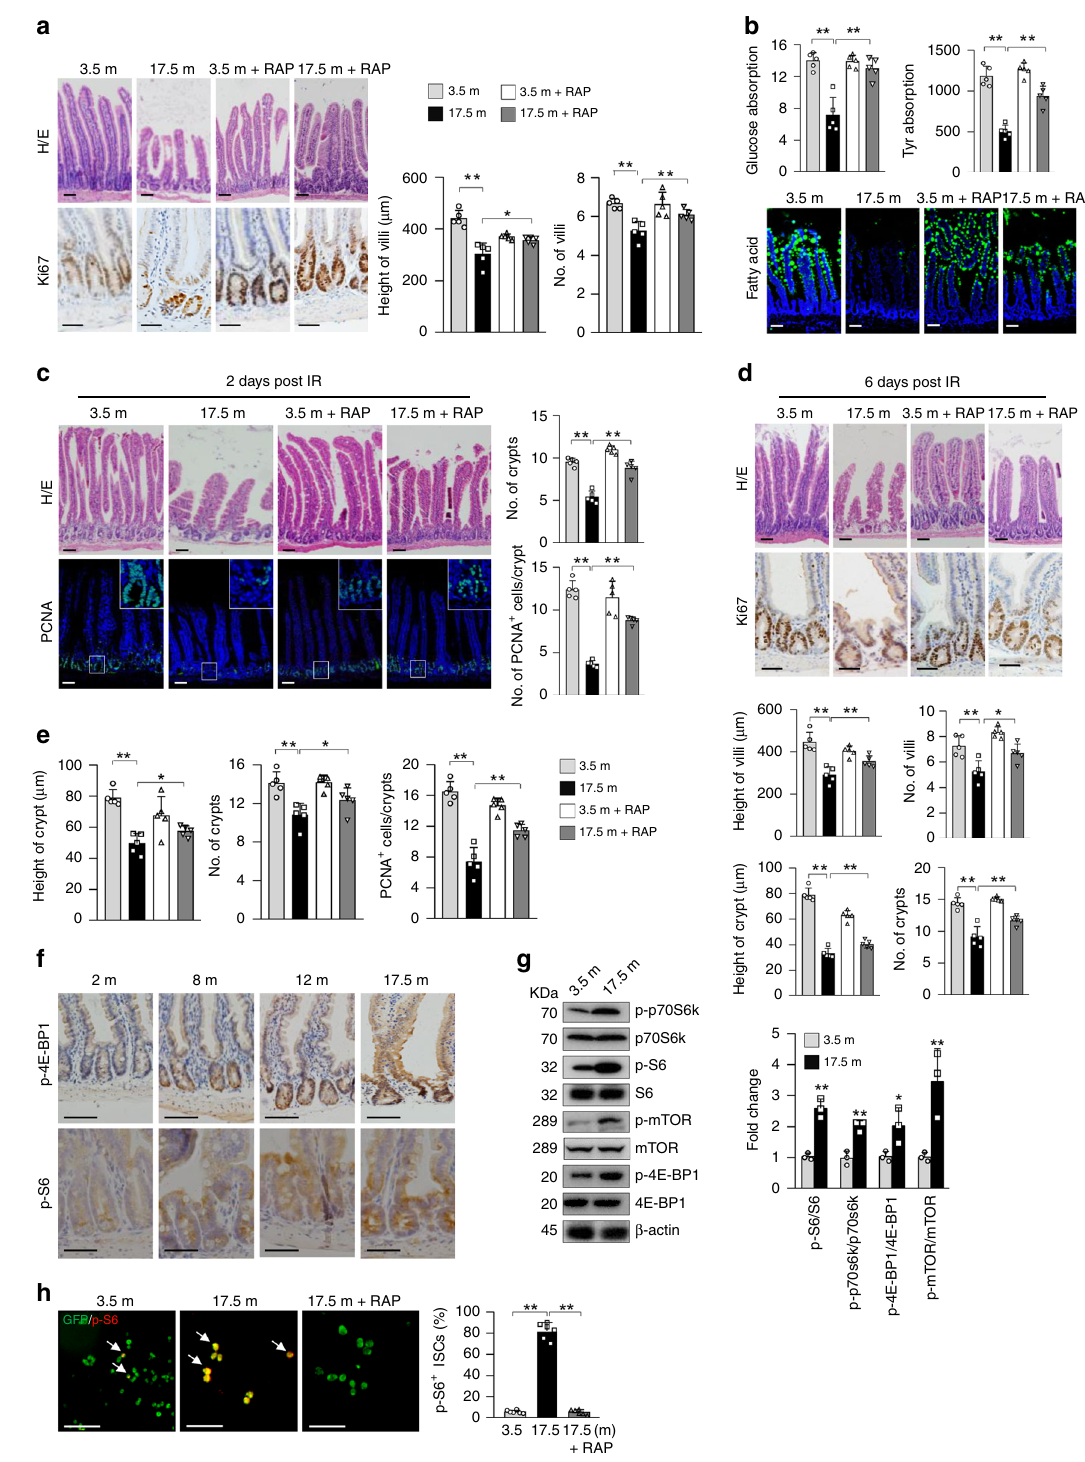
Tsc1 ablation in IECs causes villus premature aging . To test whether mTORC1 activation causes villus aging, we ablated Tsc1 , a disease gene encoding an mTOR suppressor, using Villin-Cre mice. Villin is expressed in all small intestinal IECs, including ISCs, but not colon crypts 41 . Villin-Cre;Tsc1 f/f mice exhibited enhanced mTOR activation in the whole villi (Supplementary Fig. 3a). We found that 2- or 3-month-old Villin-Cre;Tsc1 f/f mice showed increases in the number and size of crypts, but insignif- icant increases in villus size (Supplementary Fig. 3b). The nutrient